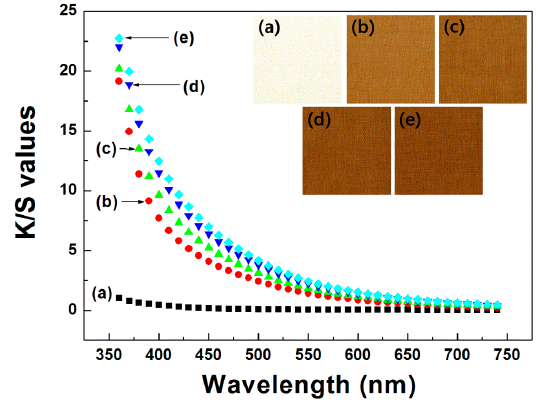
Figure 4. Color strength (K/S) values of wool fabrics dyed with spent coffee extract at 90 ◦ C as a